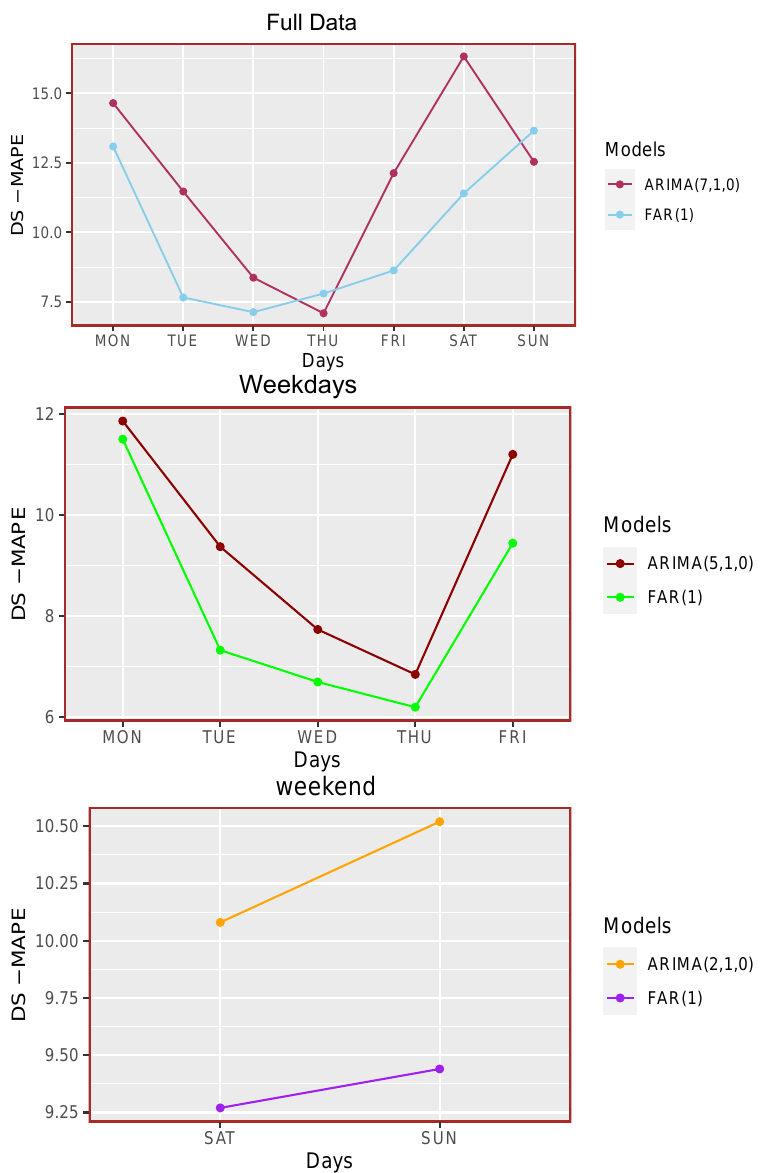
Figure 5. Out-of-sample forecasts day specific MAPE (DS-MAPE) values for traffic flow data by (upper panel) FAR(1) and ARIMA(7,1,0) for full data (middle panel) FAR(1) and ARIMA(5,1,0) for weekdays only and (lower panel) FAR(1) and ARIMA(2,1,0) weekends